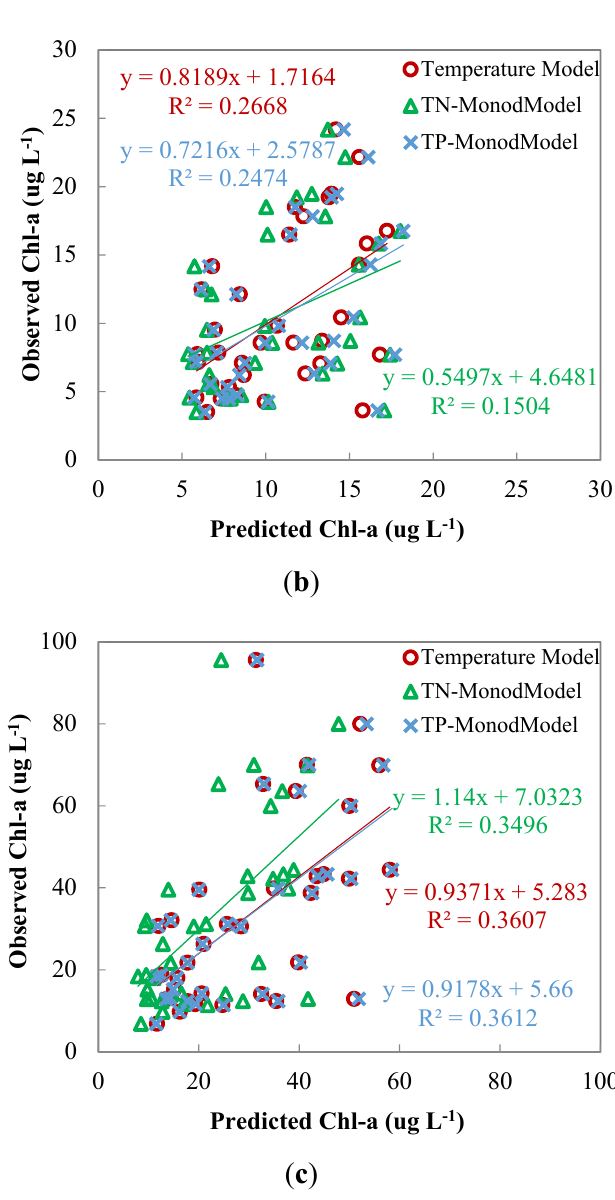
Figure 5. Observed and predicted Chlorophyll a (Chl-a) concentrations for the validation periods by the modified Monod model with temperature as the sole independent variable (referred to as the temperature model), the modified Monod model with temperature and total nitrogen (TN) as independent variables (referred to as TN-MonodModel), and the modified Monod model with temperature and total phosphorus as independent variables (referred to as TP-MonodModel) for: ( a ) Meiliang Bay at the three-day measurement interval in 2011; ( b ) Main Lake at the monthly measurement interval from 2008 to 2010; and ( c ) Meiliang-Zhushan Bay at the monthly measurement interval from 2008 to 2010. In contrast, for the monthly time interval, temperature had a greater influence on algal growth than either TN or TP (Figures 2c–f, 3c–f, and 4c–f). For both the calibration and validation period, temperature and Chl-a varied synchronically: increasing from January to June and then decreasing from July to December, which means that TN and TP concentrations had a minimal effect on Chl-a